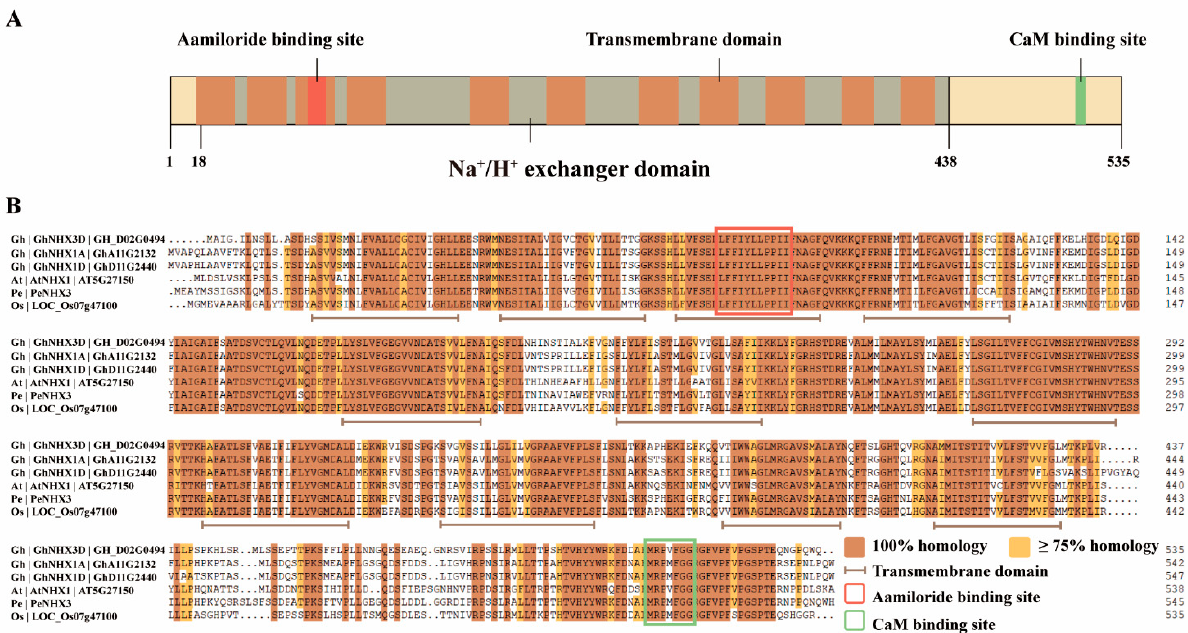
Figure 1. Protein sequence analysis of GhNHX3D . ( A ) Protein domain structure of GhNHX3D and ( B ) amino acid sequence alignment of GhNHX3D with vacuolar NHX proteins from other plants. The brown mark represents the predicted transmembrane domain, the red mark represents the amiloride binding site, the green mark represents CaM binding site, and the gray mark represents the Na + /H + exchanger domain. Gh: Gossypium hirsutum ; At: Arabidopsis thaliana ; Pe: Populus euphratica ; Os: Oryza sativa .